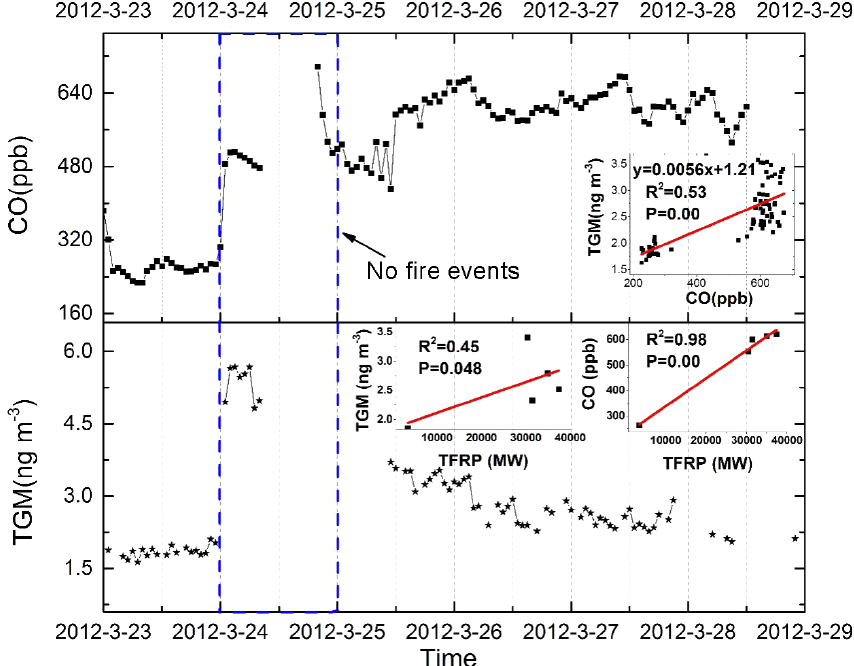
Figure 14. Correlation of TGM and CO ( R 2 = 0.53), correlations between TFRP and CO ( R 2 = 0.98) and TGM ( R 2 = 0.45) in 23–29 March 2012 during the non-ISM period